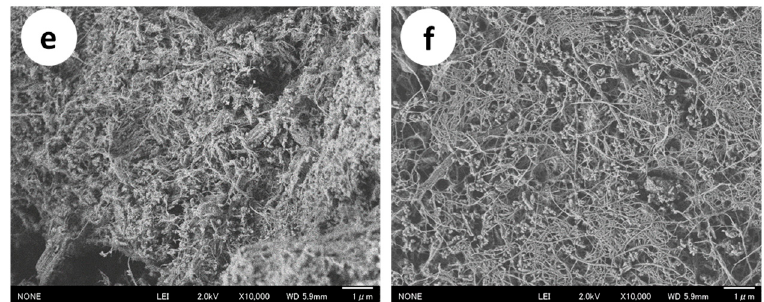
Figure 1. FE-SEM micrographs of crab shells after ( a ) 0; ( b ) 1; ( c ) 5; ( d ) 10; ( e ) 30; and ( f ) 50 passes through the high pressure water jet system. The scale bar length is 1 µm.